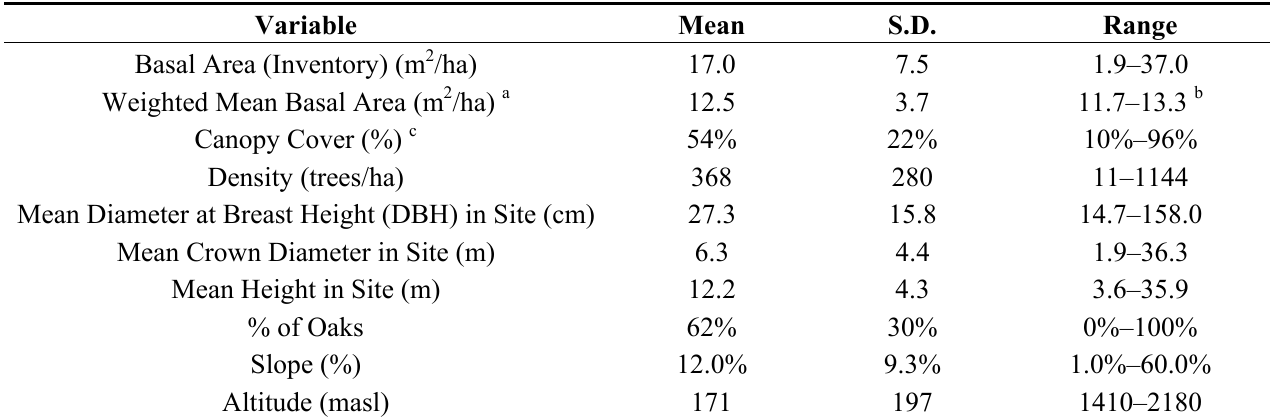
Table 2. General characteristics of the forest inventory at plot level in oak-pine forest in La Primavera, México (mean, standard deviation and range) (Adapted from